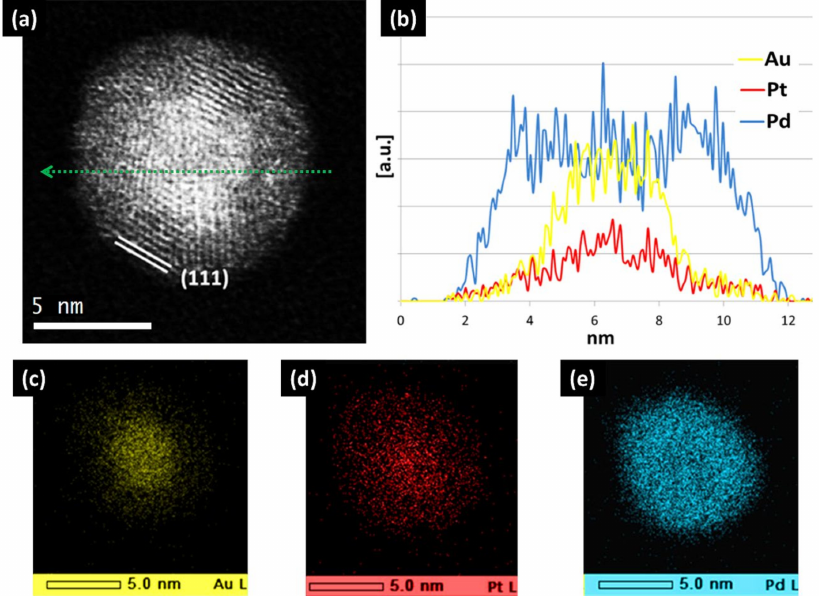
Figure 6. ( a ) HR-STEM-HAADF micrograph of a multifaceted PdPtAu nanoparticle displaying fivefold symmetry and ( b ) its corresponding EDS line scan across the nanoparticle diameter (dashed green line), indicating the Au/Pt-rich core@Pd-rich shell configuration. ( c – e ) Local elemental mapping by EDS verifying the core − shell structure (the intensity corresponds to counts). Reproduced from